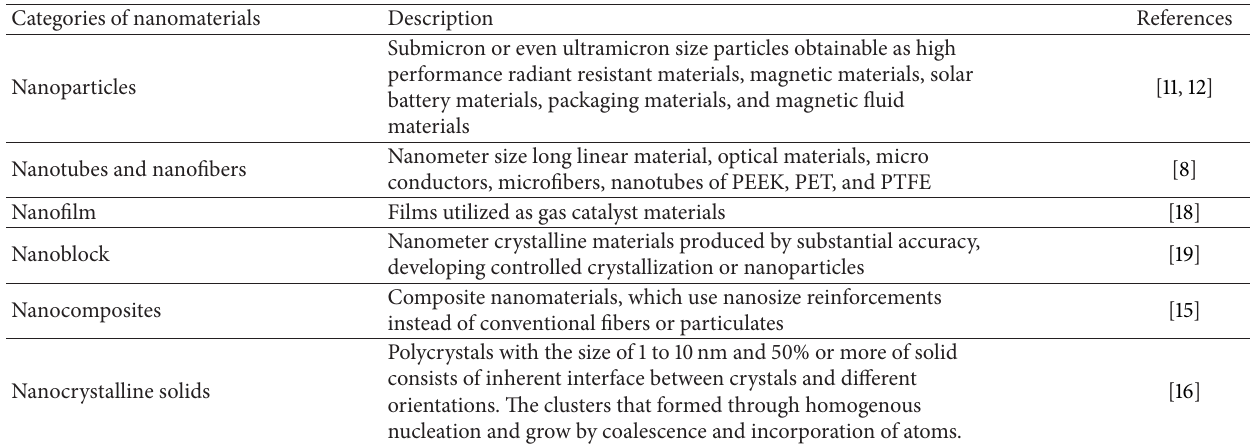
Table 1: Classification of